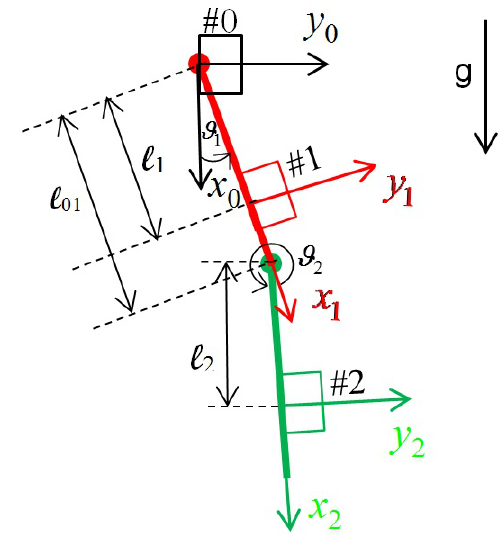
Figure 1. Kinematic scheme of a